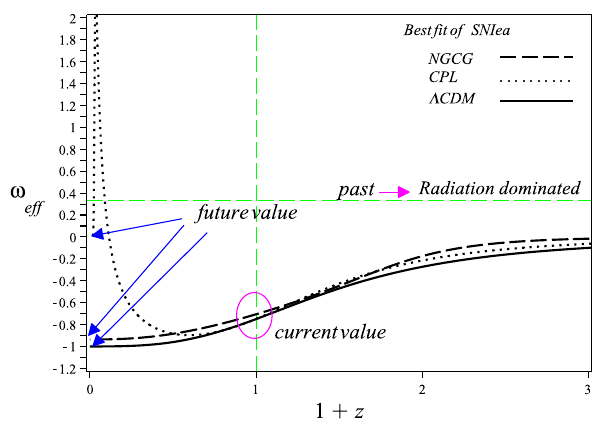
Fig. 2 The best fitted trajectory of Equation of State for NGCG , (cid:11) CDM and CPL model in redshift range − 1 < z < 3